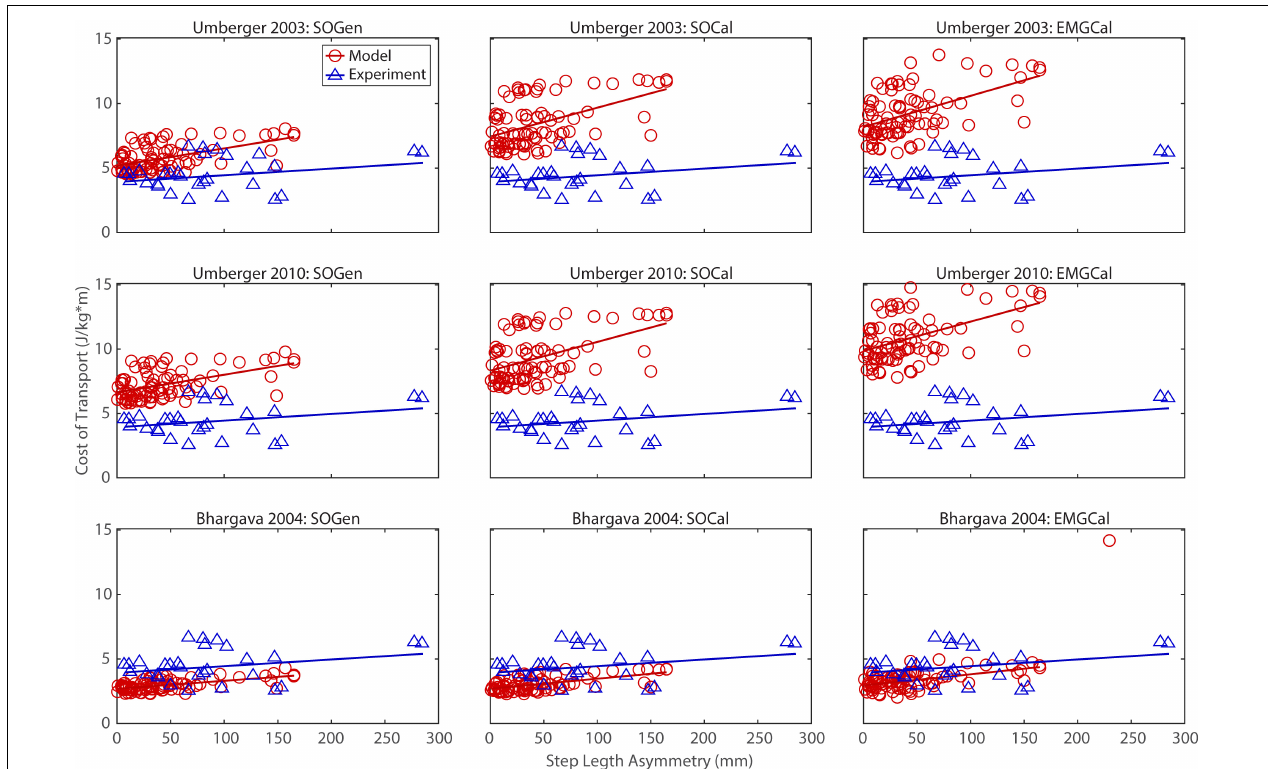
FIGURE 3 | Comparison of model predicted (red circles) and experimentally measured (blue triangles) cost of transport as a function of step length asymmetry between paretic and non-paretic legs. See Figure 2 caption for additional